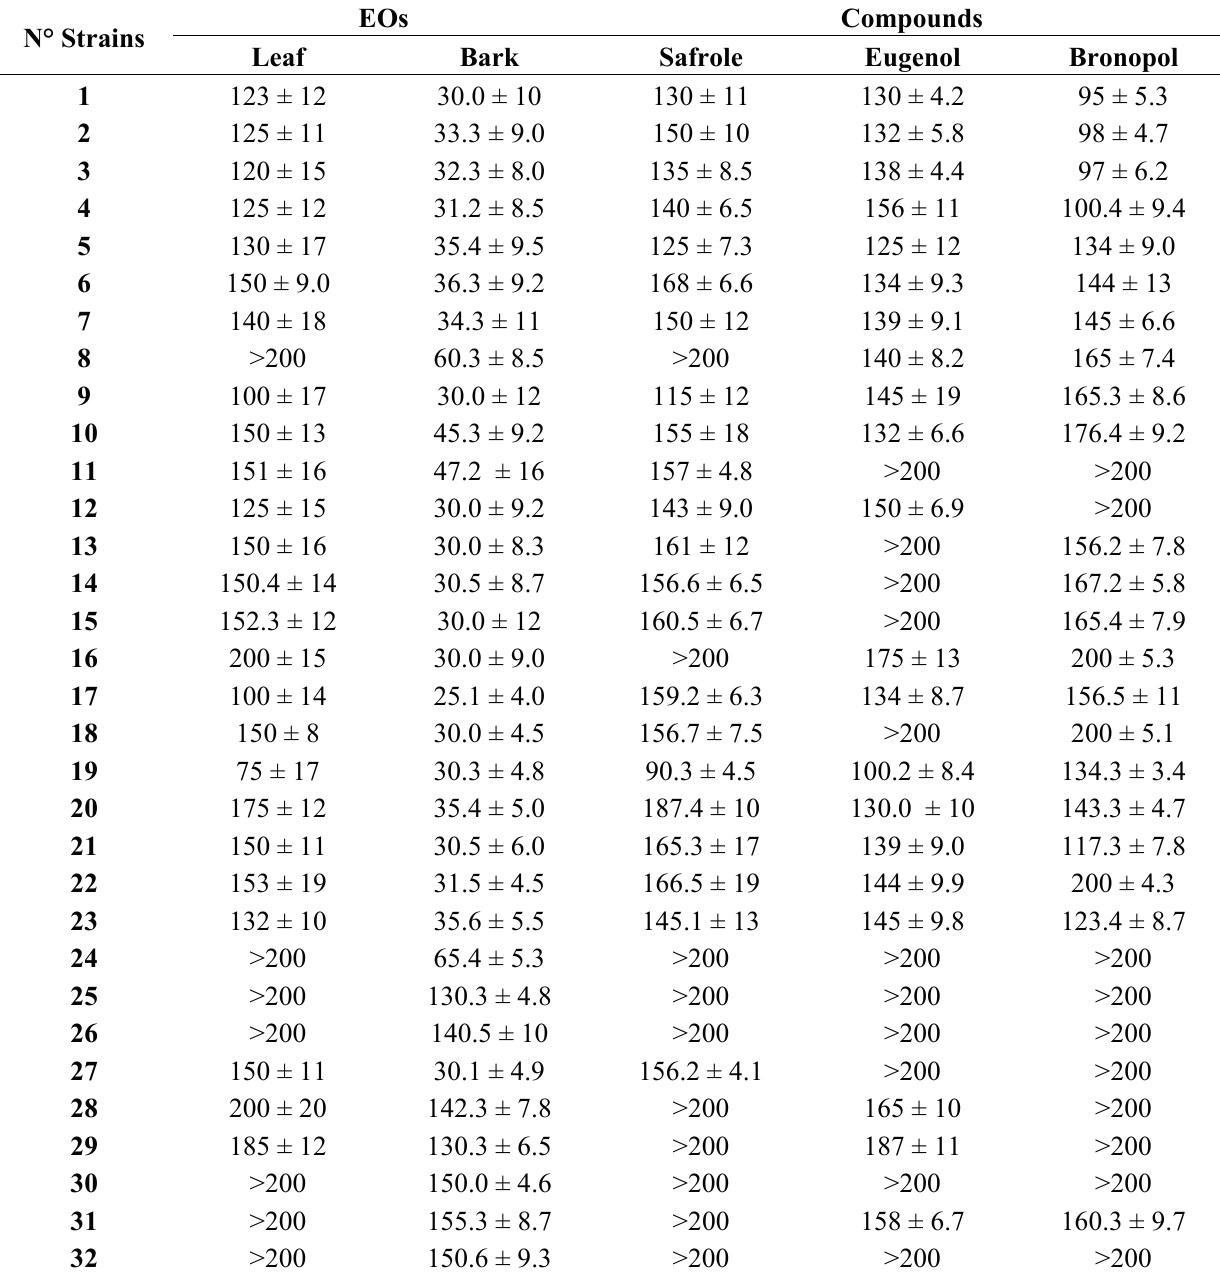
Table 2. MIC values a of leaf and bark EOs against mycelium at 48